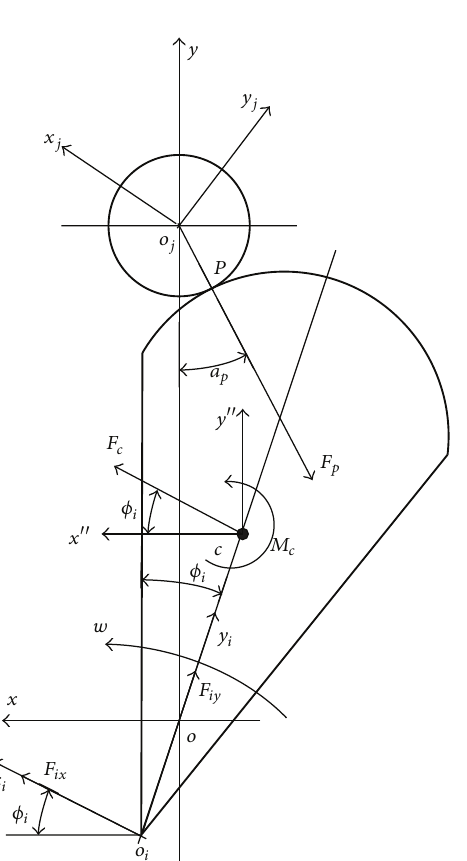
Figure 4: The dynamic simplified model of the radial stroke loading